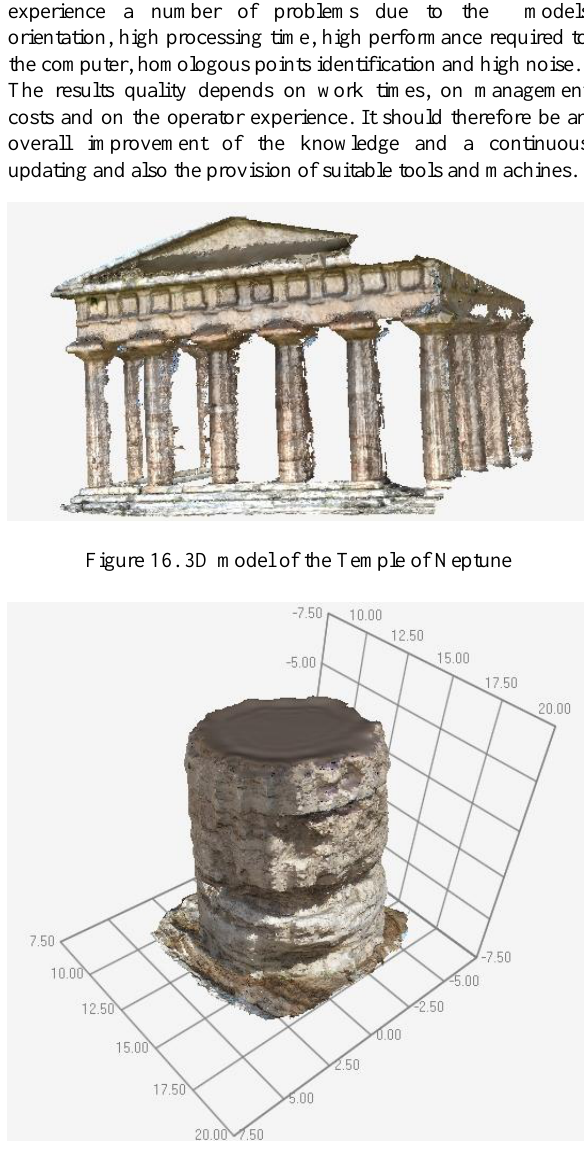
Figure 20. 3D model of the